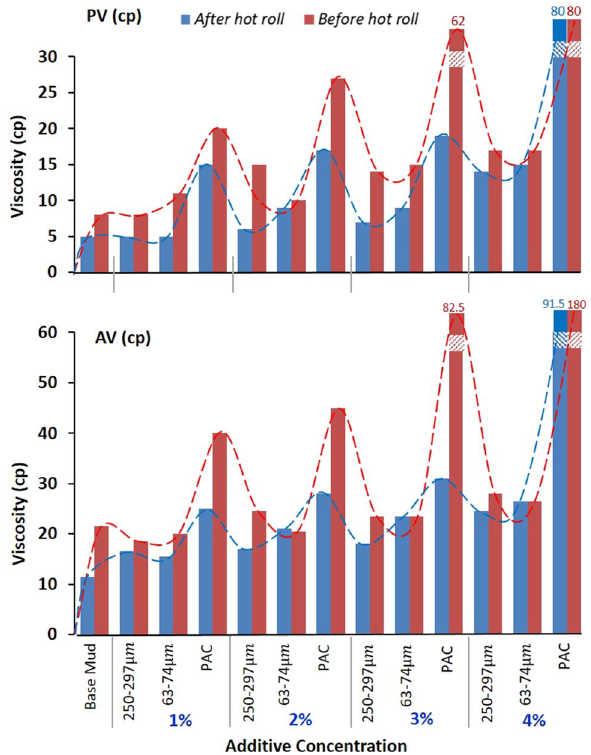
Fig. 14 A comparative analysis for PV, AV at varying concentrations before and after hot roll showing gradual increase in both the values as the concentration of the additives increased from 1 to